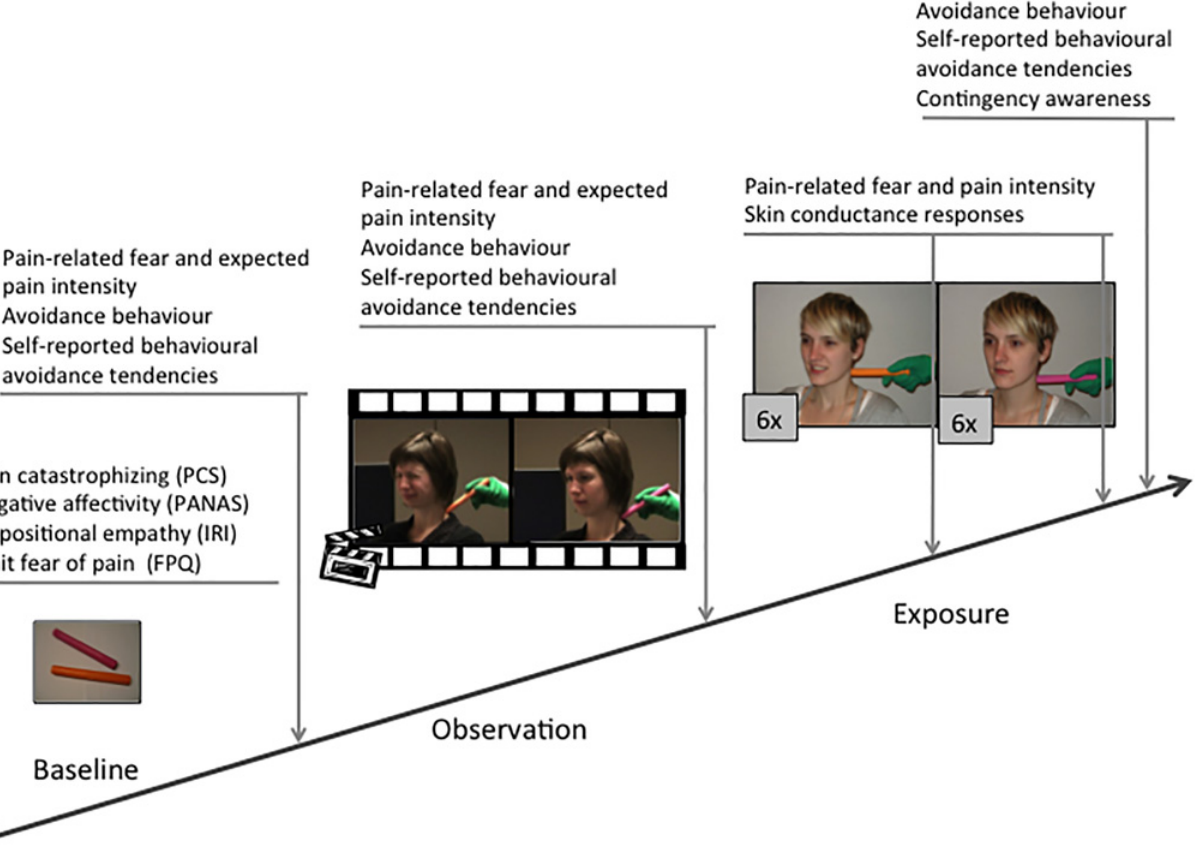
Fig 1. Graphical overview of the experimental procedure, with the measurements during the baseline, observation, and exposure phase. During the observation phase, one colour was associated with painful facial expressions of the video models (left), while the other colour was paired with neutral expressions